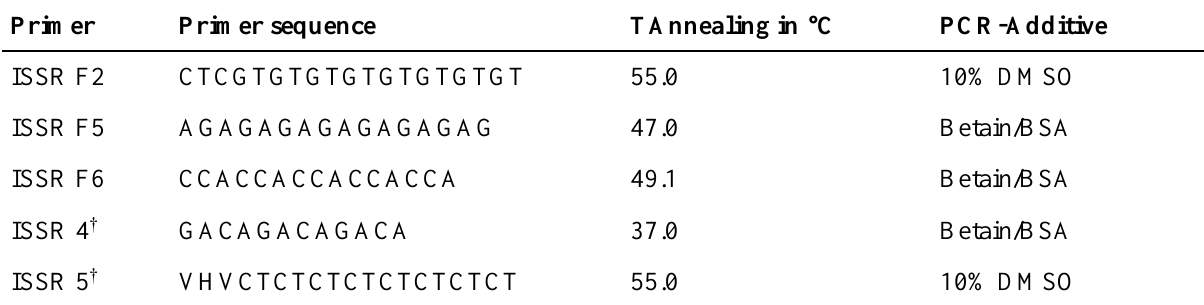
Table 2. Used ISSR-Primer after Dogan et al. (2010) and Bradeen et al. (2002) †. Primer